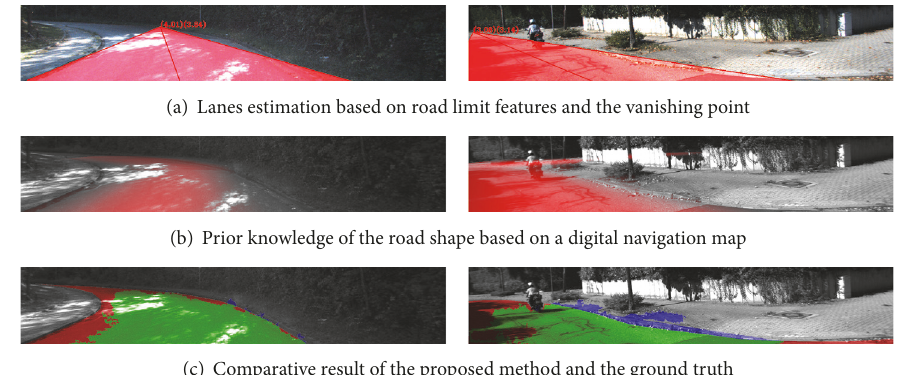
Figure 17: Qualitative results of the proposed method in narrowed roads. The meaning of the colors is as follows: TP: green; FP: blue; and FN: